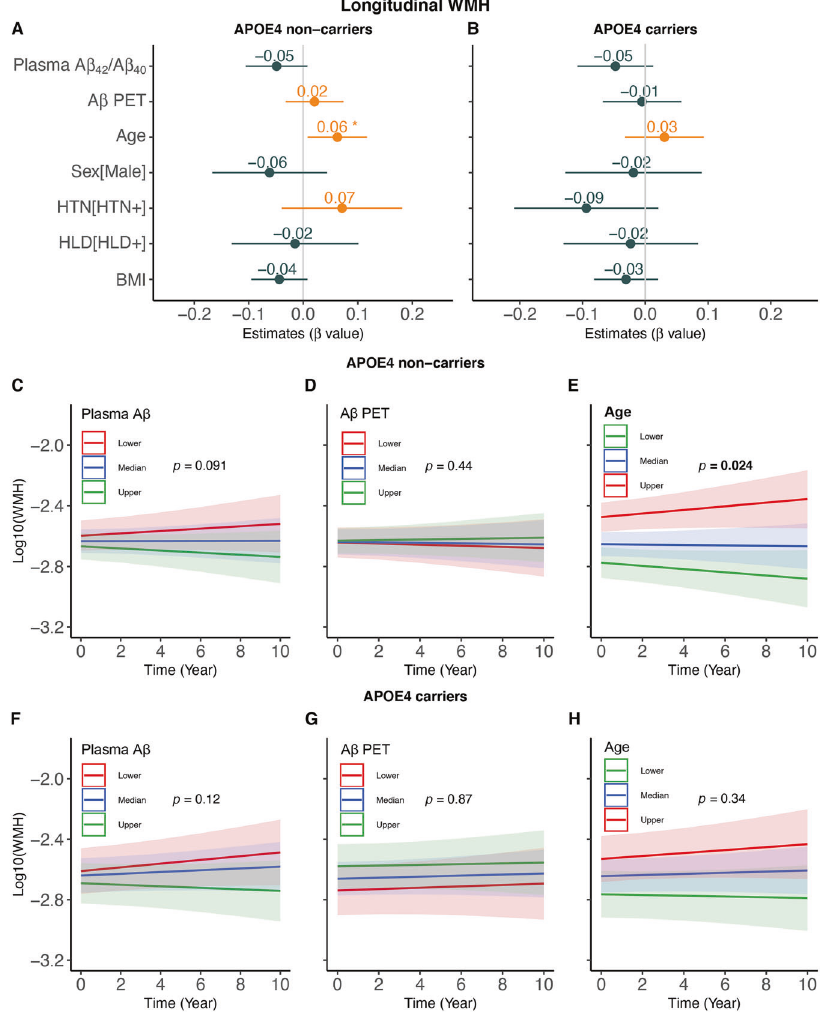
Fig. 1 Predictors of longitudinal WMH changes. The estimated β values of each predictor for longitudinal WMH changes in linear mixed effect models in ( A ) APOE- ε 4 non-carriers and ( B ) APOE- ε 4 carriers. Prediction of longitudinal WMH changes over time by baseline plasma A β 42 /A β 40 , A β PET and age in APOE- ε 4 non-carriers ( C – E ) and carriers ( F – H ). Note: lower, median and upper represent the value that cuts off the fi rst 25%, 50% and 75% of the data when it is sorted in ascending